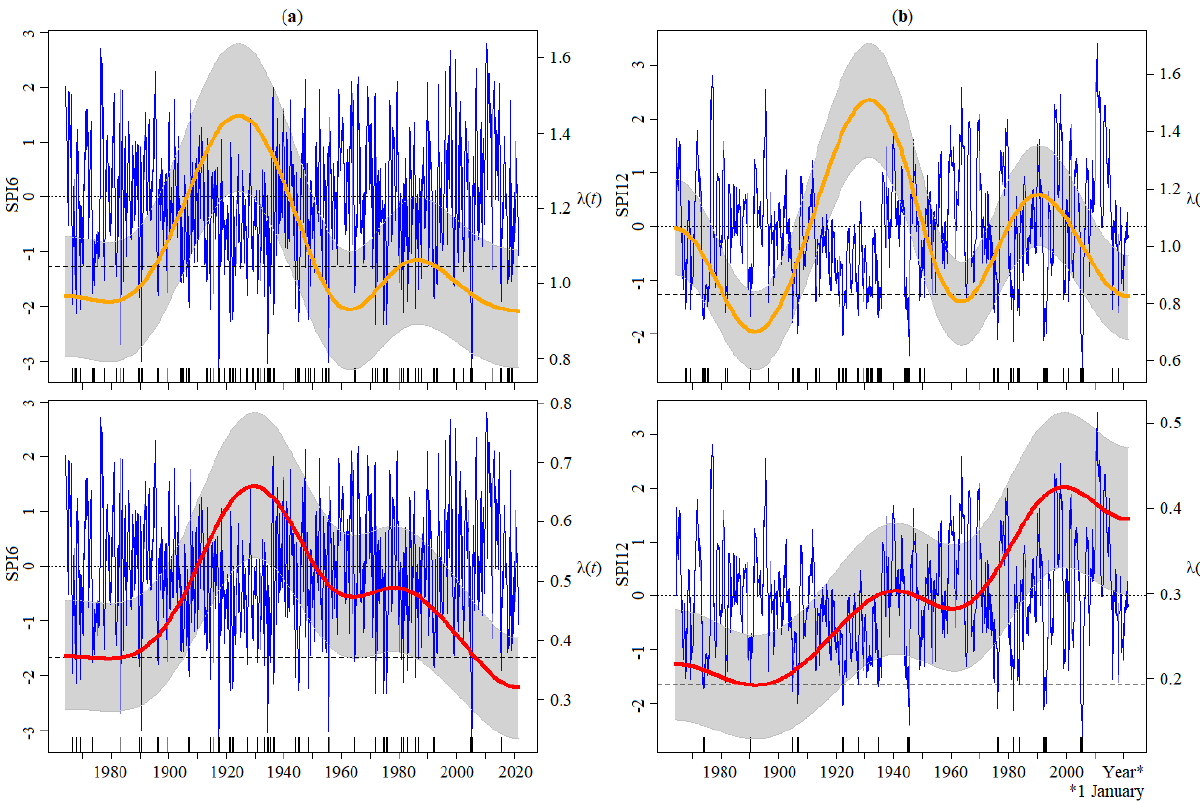
Figure 9. Time dependent occurrence rates from 1 October 1864 to 30 September 2021 of periods under drought conditions for ( a ) SPI6 and ( b ) SPI12: SPI series (in blue), drought thresholds (horizontal dashed lines), number of periods under drought conditions per year, λ ( t ) , of severe (in orange, top plots) and extreme (in red, bottom plots) droughts, and confidence band (grey area). The vertical ticks represent the time data of the